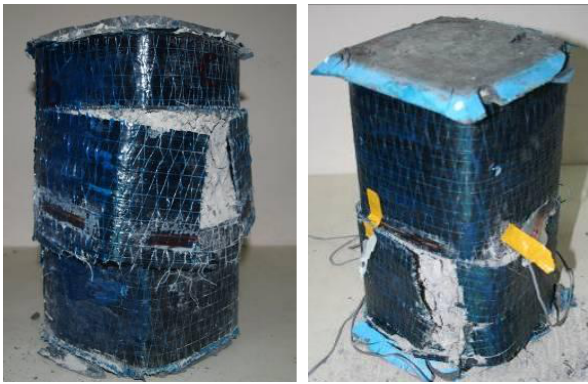
Figure 10. Typical failure modes of residual capacity test